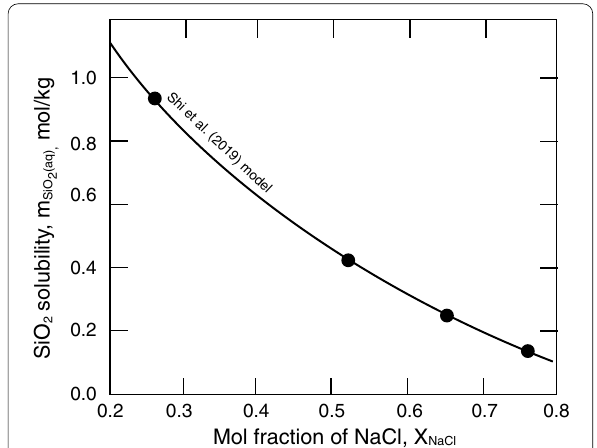
Fig. 14 Solubility of SiO 2 in H 2 O–NaCl fluid as a function of salinity at 700 °C and 1 GPa calculated with the model of Shi et al. (2019) and compared with experimental data from Newton and Manning (2000). Modified from Shi et al.